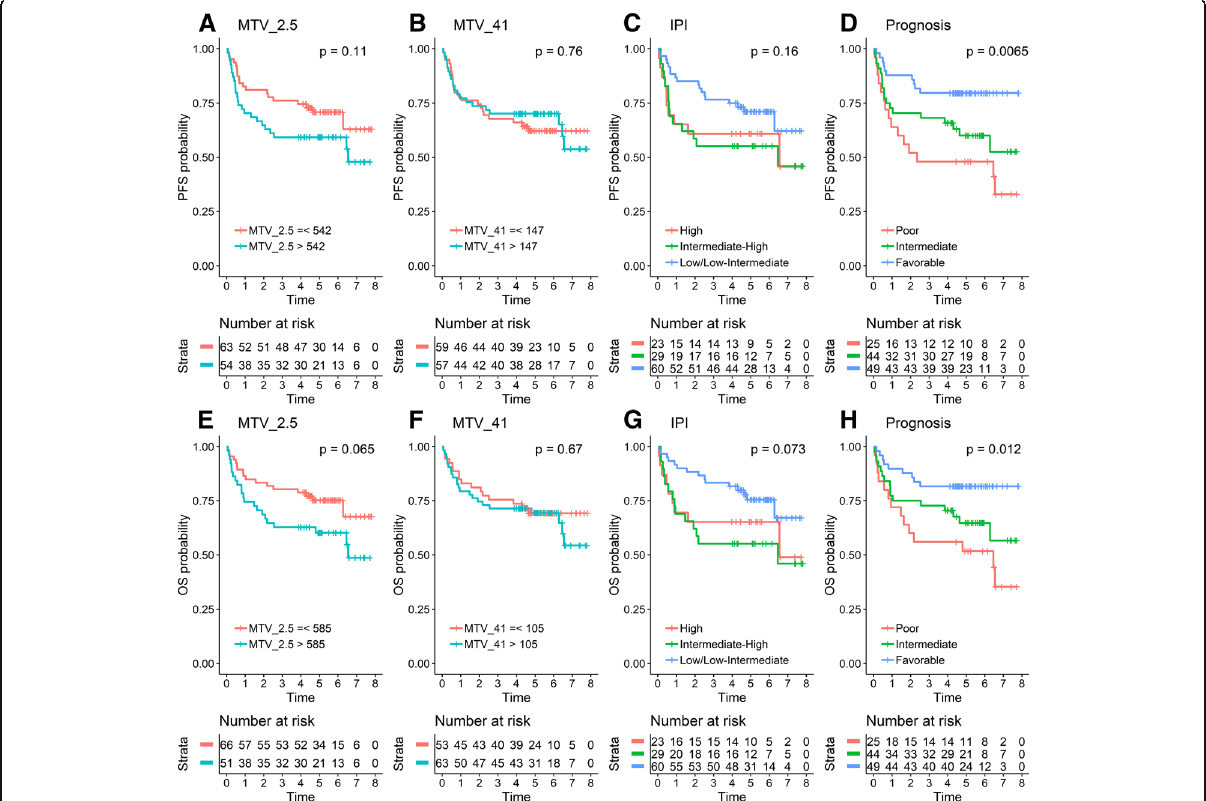
Fig. 2 Progression-free survival (PFS) and overall survival (OS) using automated metabolic tumor volume (MTV) measurements ( a , b , e, f ), IPI ( c, g ) vs. visual assessment of prognosis by expert readers ( d, h ). As seen, the visual PET assessment of prognosis significantly outperformed both the automated PET metrics as well as the prognosis by the treating hematologist (IPI)